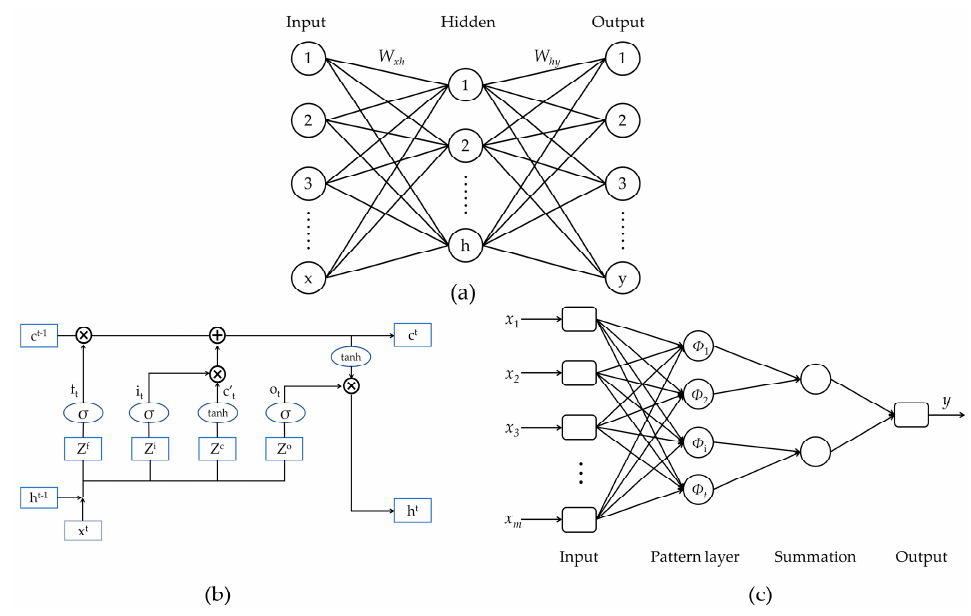
Figure 3. Artificial neural network architectures: ( a ) the typical structure of an ANN; ( b ) the LSTM architecture; ( c ) the PNN architecture.